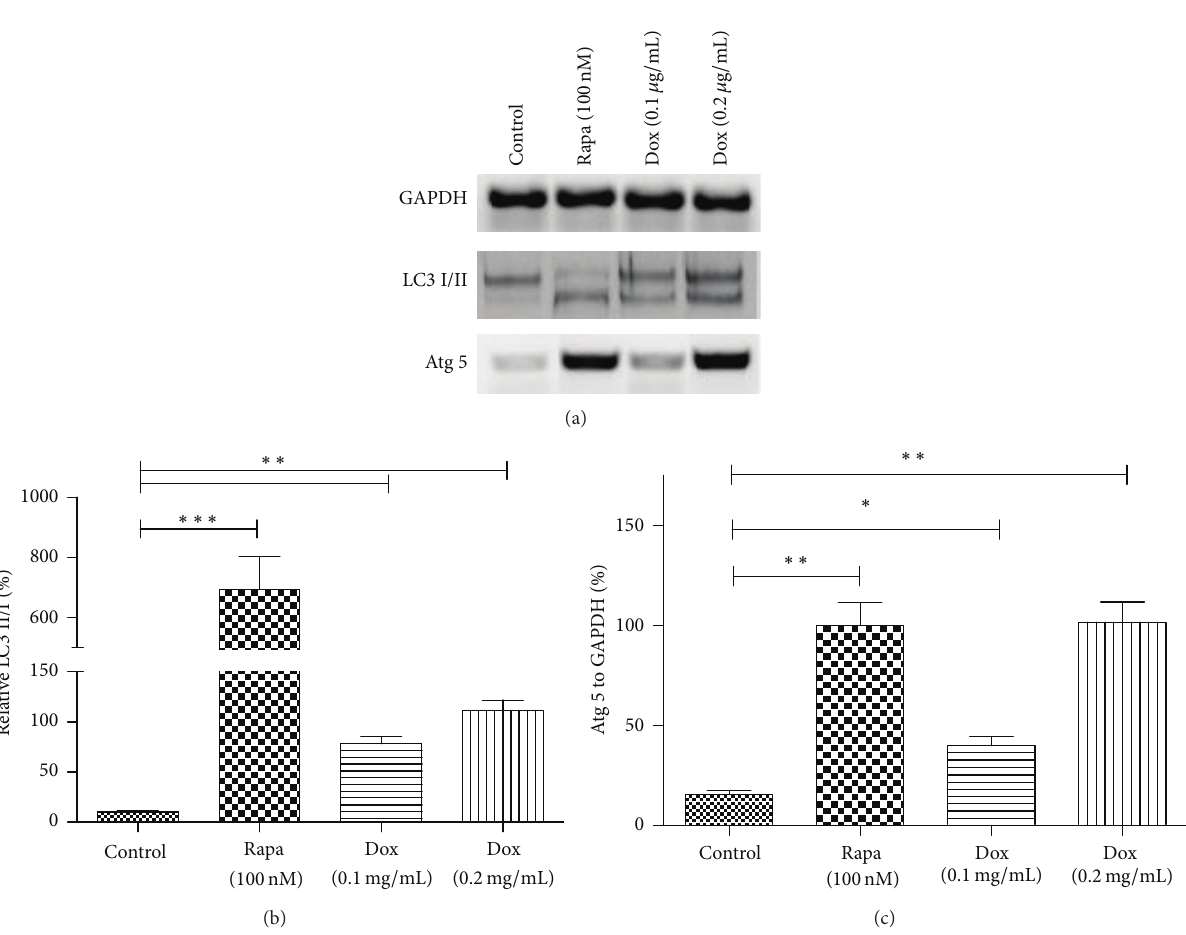
Figure 2: Dox promotes the conversion of LC3-I to LC3-II and increases Atg 5 expression. (a) Western blotting results of U-2 OS cells with Dox (0.1 or 0.2 𝜇 g/mL) or Rapa (100nM) treatment. (b) Quantitative analysis of the conversion of LC3-I to LC3-II in various